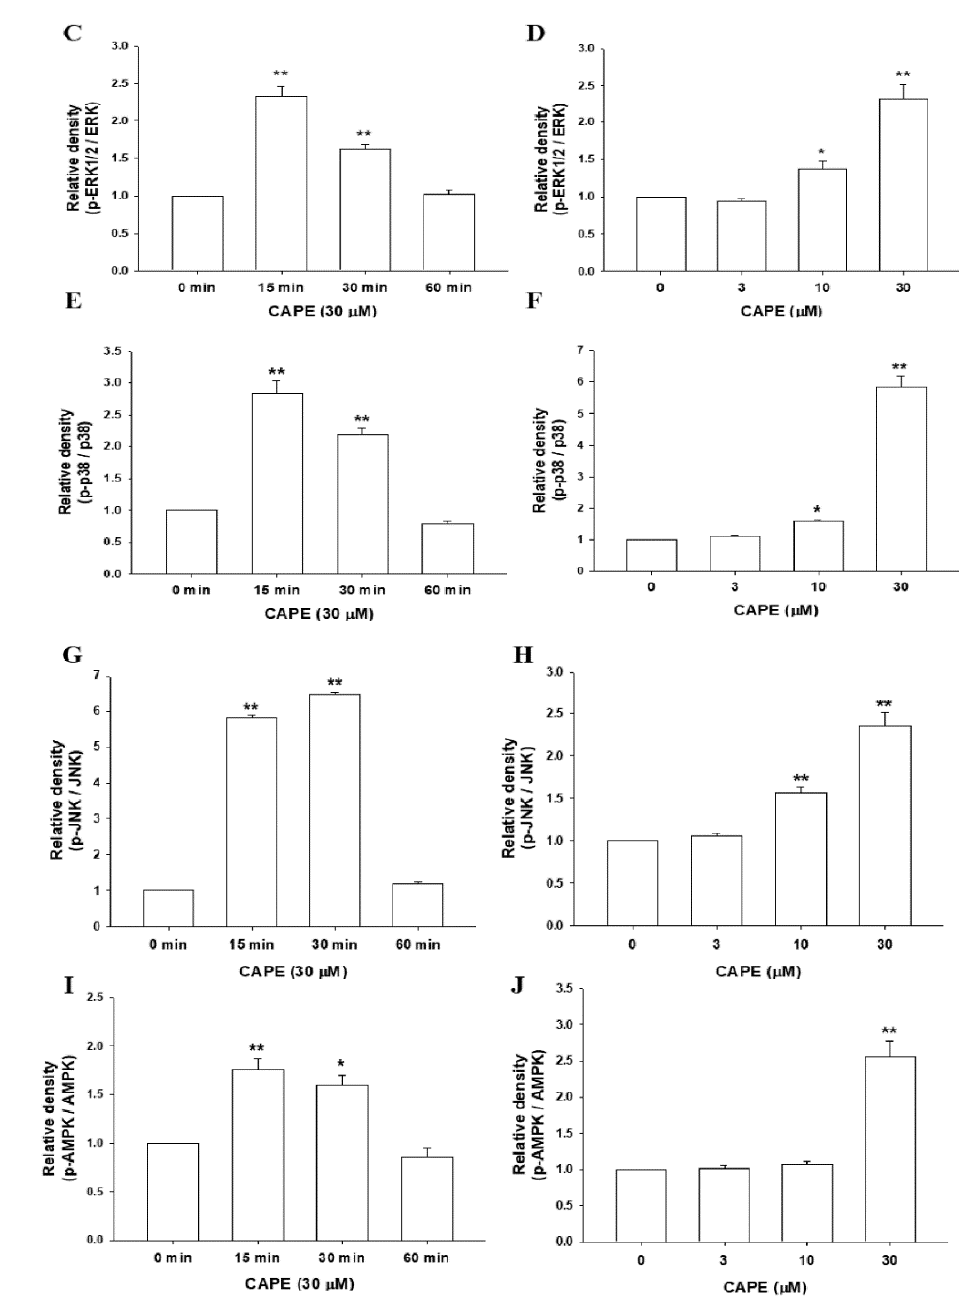
Figure 5. CAPE increases phosphorylation of ERK, p38, JNK, and AMPK α 1/2 in PC-3 cells. ( A ) Time courses of ERK, p − ERK, p38, p − p38, JNK, p − JNK, AMPK α 1/2, and p − AMPK α 1/2 expressions were determined using immunoblot assays after various periods of 30 µ M CAPE treatments in PC-3 cells. ( B ) Dose responses of ERK, p − ERK, p38, p − p38, JNK, p − JNK, AMPK α 1/2, and p − AMPK α 1/2 were determined using immunoblot assays after 30 min of various concentrations of CAPE treatments in PC-3 cells. The quantitative data are expressed as the intensity bands of the phosphorylation proteins relative to the total protein levels for ERK ( C , D ), p38 ( E , F ), JNK ( G , H ), and AMPK ( I , J ). * p < 0.05, ** p <